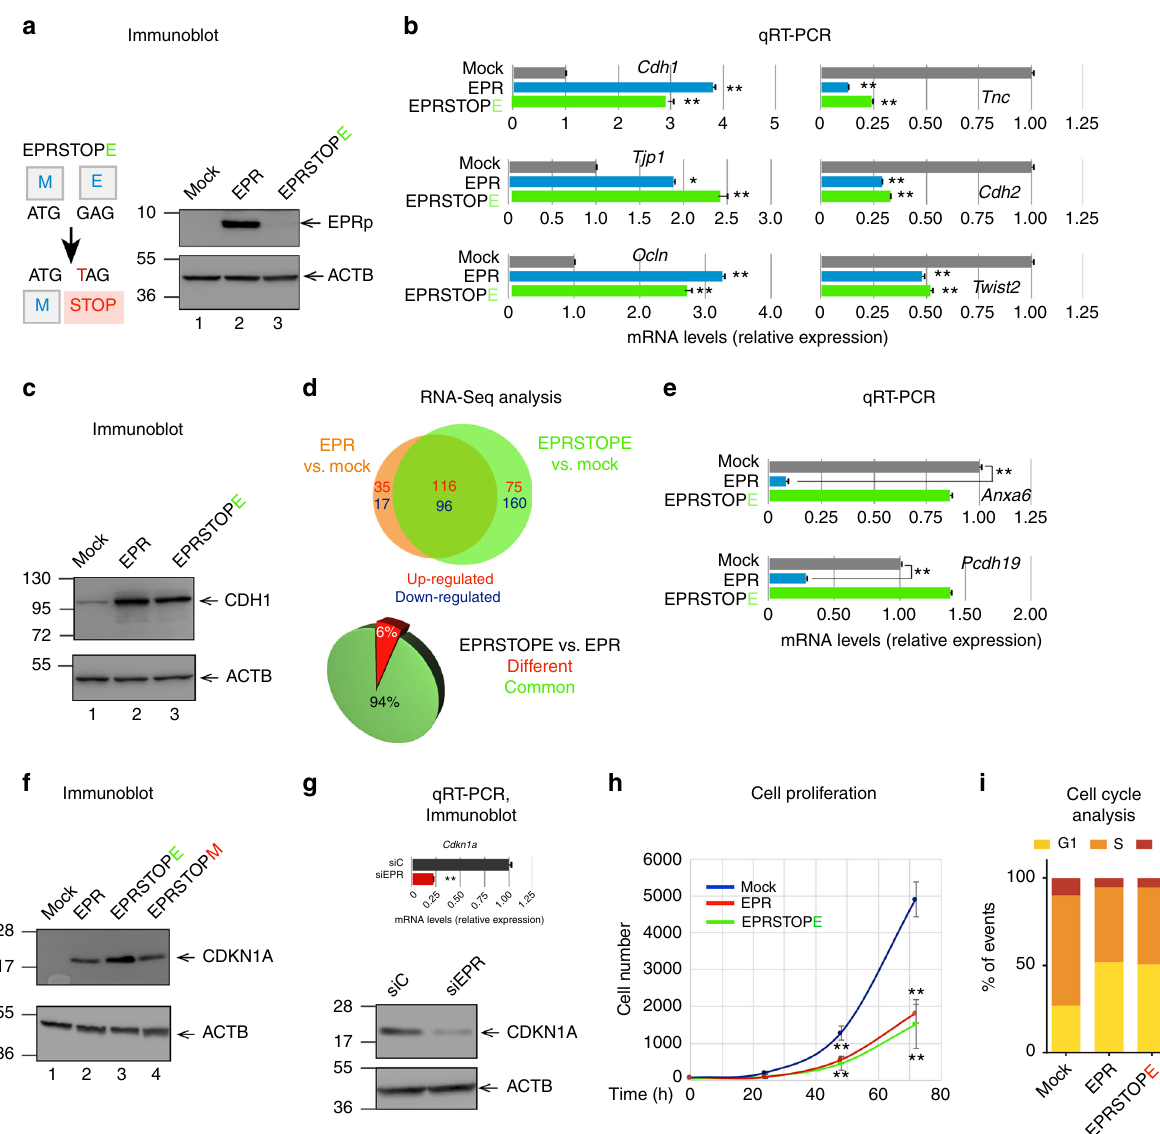
Fig. 3 EPR overexpression reshapes NMuMG cells transcriptome and reduces cell proliferation. a Schematic of the point mutation introduced in the second codon of the EPR ORF to generate EPRSTOPE (left panel). HEK-293 cells were transiently transfected with either EPR or EPRSTOPE and the translation of EPR was assessed by immunoblotting (right panel). b qRT-PCR analysis of the indicated transcripts in either mock, EPR- or EPRSTOPE-expressing NMuMG cells. c Immunoblot analysis of total cell extracts from either mock, EPR- or EPRSTOPE-overexpressing NMuMG cells. d Upper panel, TopTable Venn diagram of the limma one-factor contrast analysis showing the overlap between transcripts either upregulated (numbers in red) or downregulated (numbers in blue) in cells stably overexpressing either EPR or EPRSTOPE compared with mock cells. Only transcripts displaying |log2 fold expression difference| > 2.5 ( p < 0.0001, Student ’ s t test) were included in further comparisons. Lower panel, Pie diagram showing the percentage of gene expression changes common to NMuMG cells overexpressing EPR and EPRSTOPE as well as the percentage of changes that can be speci fi cally attributed to the EPR translation. e qRT-PCR analysis of the indicated transcripts in either mock, EPR- or EPRSTOPE-overexpressing NMuMG cells. f Immunoblot analysis of total cell extracts from either mock, EPR-, EPRSTOPE- or EPRSTOPM-overexpressing NMuMG cells. g qRT-PCR analysis of Cdkn1a mRNA levels in either control siRNA (siC) or siEPR-transfected NMuMG cells (upper panel). Immunoblot analysis of total cell extracts from either control siRNA (siC) or siEPR- transfected NMuMG cells (lower panel). h Proliferation analysis (Operetta CLS High-Content Analysis System) of either mock, EPR- or EPRSTOPE- overexpressing NMuMG cells. i Cell cycle distribution in cultures grown at similar density (near 90% con fl uence). Cell cycle was analyzed by fl ow cytometry after double staining with EdU and propidium iodide of either mock, EPR- or EPRSTOPE-overexpressing NMuMG cells. Bars plot the relative proportion of cells in G1, S, and G2 phases for each cell line. The values of qRT-PCR experiments shown are averages (±SEM) of three independent experiments performed in triplicate. Statistical signi fi cance: * p < 0.01, ** p < 0.001 (Student ’ s t test). For immunoblots, the indicated antibodies were used; the position of molecular mass markers is indicated on the left and representative gels are